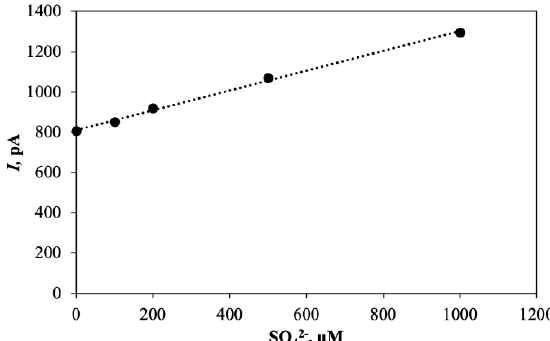
Figure 7. Calibration curve for SO 42 − biosensor with 70 um tip. The 90% response time was 5 min due to a long diffusion path through a 400 µm layer of bacterial biomass. (Data was obtained from the laboratory of the presented authors).